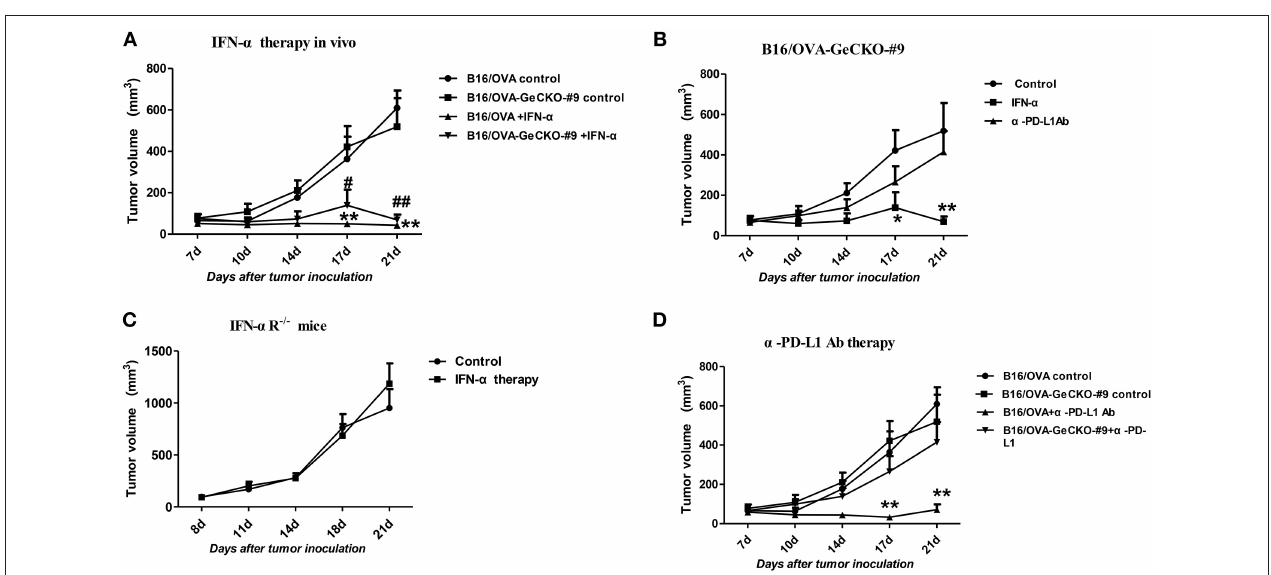
Frontiers in Immunology |